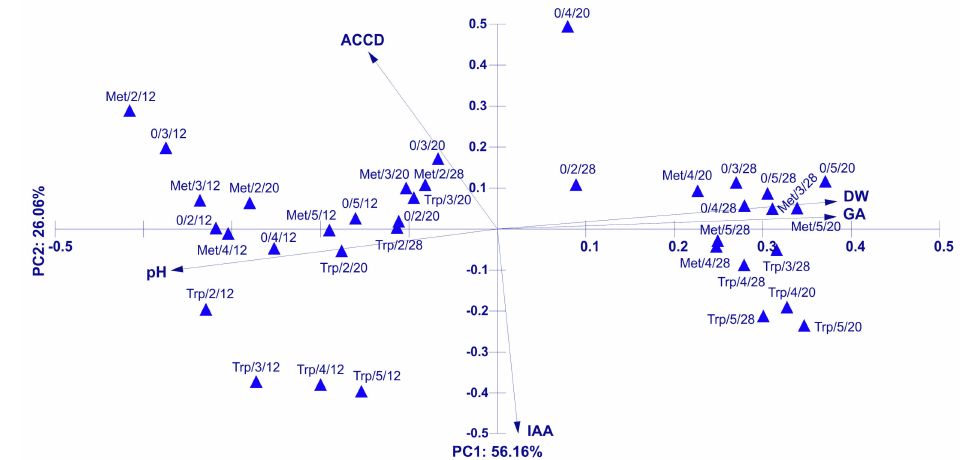
Figure 12. The ordination diagram showing the result of the principal component analysis (PCA) for the physical parameters of the Trichoderma DEMTkZ3A0 strain growing on the medium without amino acid (0) and with two amino acids: tryptophan (Trp) or methionine (Met) analyzed in four days of incubation (2, 3, 4, and 5 days) at three temperatures (12, 20, 28 ◦ C). ACCD—average activity of ACC-deaminase; IAA—average concentration of indole acetic acid; GA—average concentration of gibberellic acid; DW—dry weight of